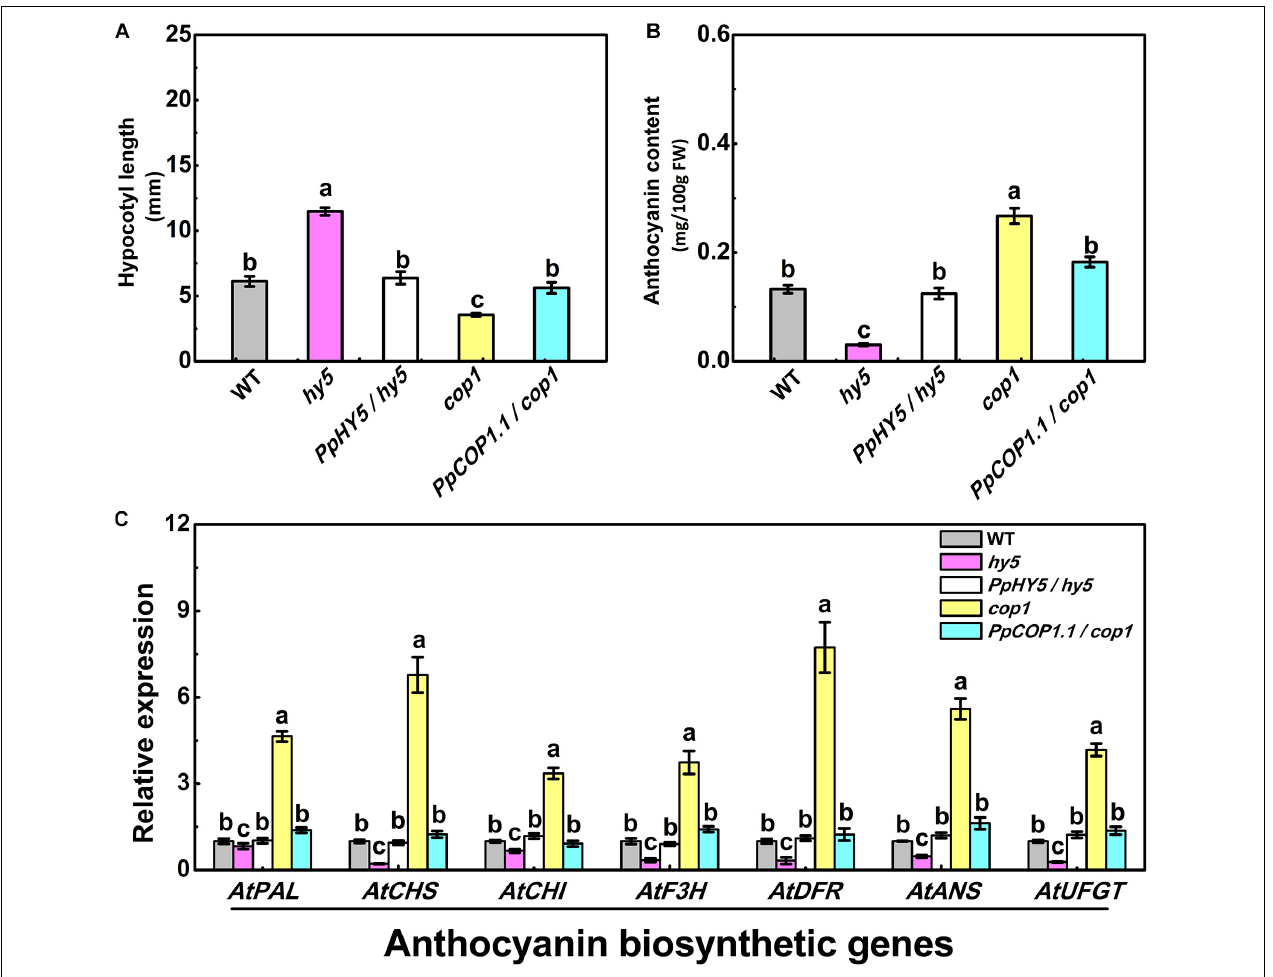
FIGURE 4 | Hypocotyl length (A) , anthocyanin content (B) and the relative expression levels of anthocyanin biosynthesis related genes (C) in 5-day-old seedlings of wild type (WT), mutant ( hy5 , cop1 ) and transgenic plants ( PpHY5 / hy5 , PpCOP1.1 / cop1 ) grown under long-day condition (16 h 40 w/m 2 white light/8 h dark cycle). For Arabidopsis transgenic plants, three independent lines for each target gene were used. Data were presented as means ( ± SE) from three independent biological replicates with 30 or more Arabidopsis seedlings collected for each replicate. Values labeled with different letters indicated a significant difference at P <